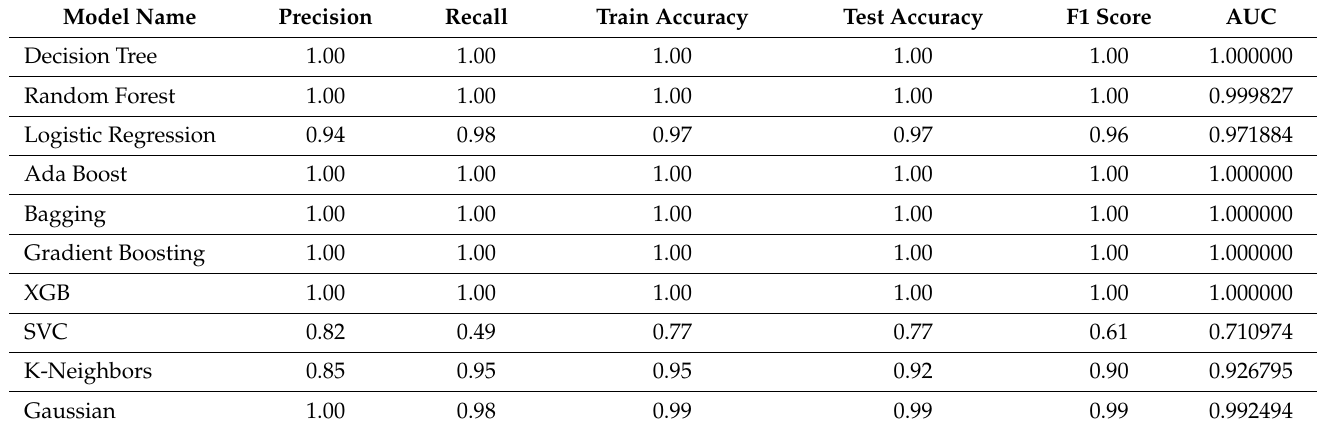
Table 5. Excluded models based on overfitting or accuracy.